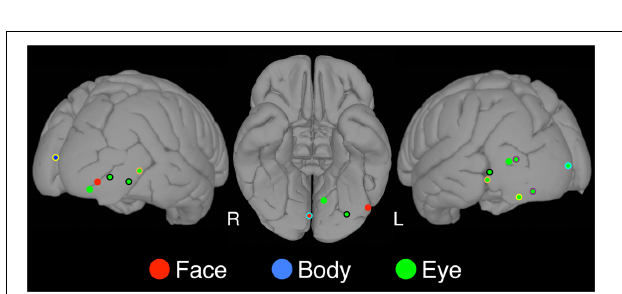
grand-average ERPs for each condition were calculated at all electrodes that were category-selective for one or more conditions. The grand-averages can therefore include sites that were selective for multiple conditions. For instance, the body-selective ERP (bottom row) includes the response recorded from the “Body,” “Face & Body,” and “Face & Eye & Body” locations. The grand average ERP was created by averaging patient ERPs, which could each include one or more electrodes. We report both the patient sample size ( N ) and the total number of electrodes. (C) The relative increase in event-related gamma power at the same category-selective sites.